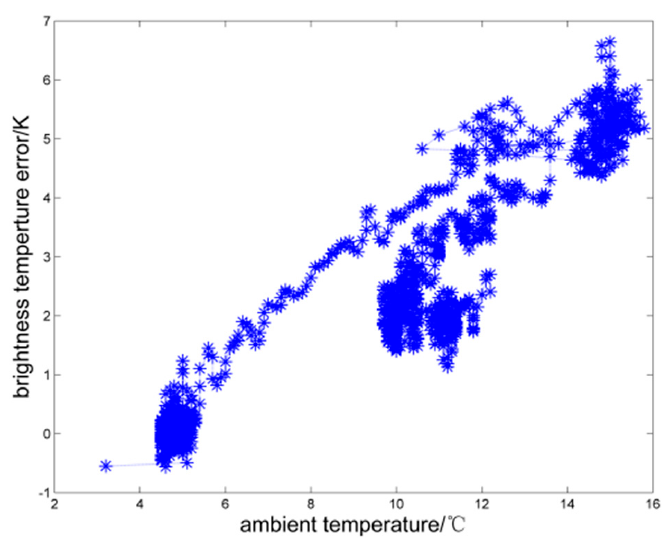
Figure 4. The relationship between measurement error and ambient temperature.